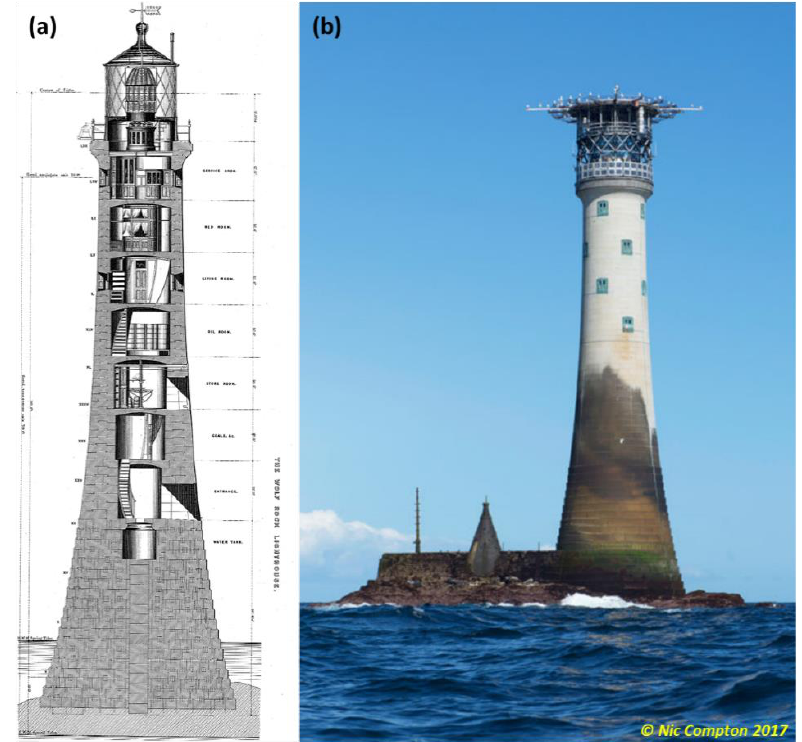
Figure 1. Wolf Rock lighthouse: ( a ) drawing by James Douglas (1870) [6] and ( b ) Wolf Rock lighthouse in 2017 (reproduced by kind permission of Nic Compton).